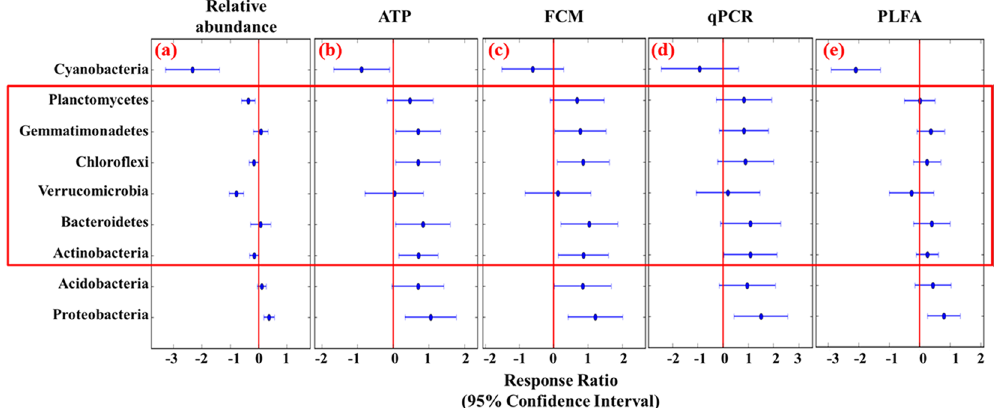
Figure 2. Response ratio for the differences between the relative abundances and estimated absolute abundances (EAA) of the major phyla in Beijing and Tibet grasslands. Significance was determined using the response ratio analysis at a 95% confidence level. The 95% CI of a response variable without overlapping with zero represent a significant result, otherwise, with non-significance. The response ratio more than zero means the abundances of Beijing more than Tibet samples, and vice versa.